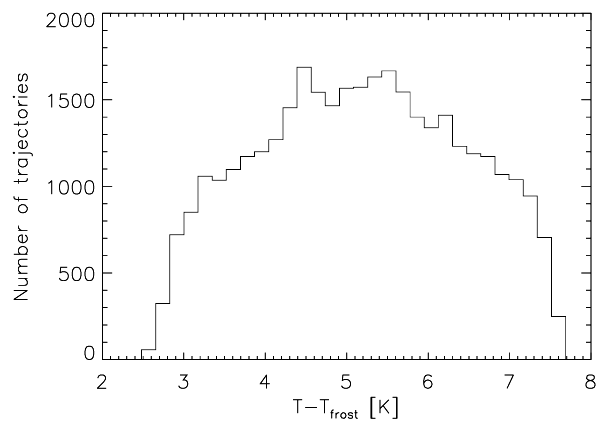
Fig. 1. A distribution showing the minimum temperature reached along each trajectory, with respect to the frost point. Trajectories were calculated back in time from points along the CALIPSO orbit path, as described in Sect. 2.3. All trajectories used to model the PSC properties along all orbits in Sect. 3 are included in the